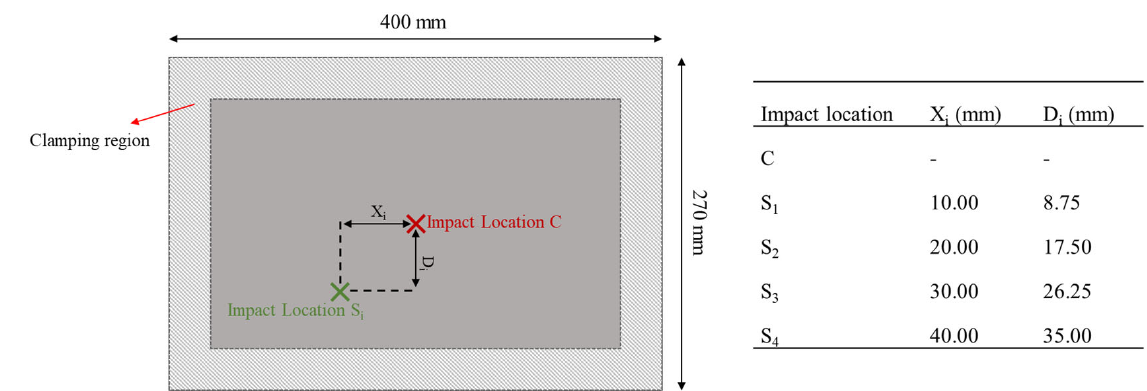
Figure 1. Impact locations on skin composite laminates.